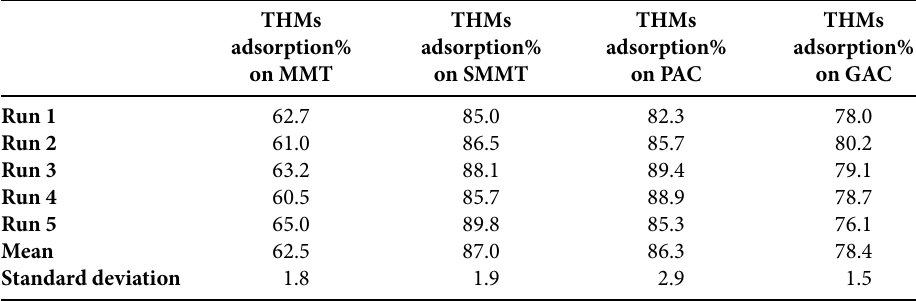
Table 3. Results of the THMs batch adsorption percentage at the same conditions for MMT, SMMT, PAC, and GAC THMs THMs THMs THMs